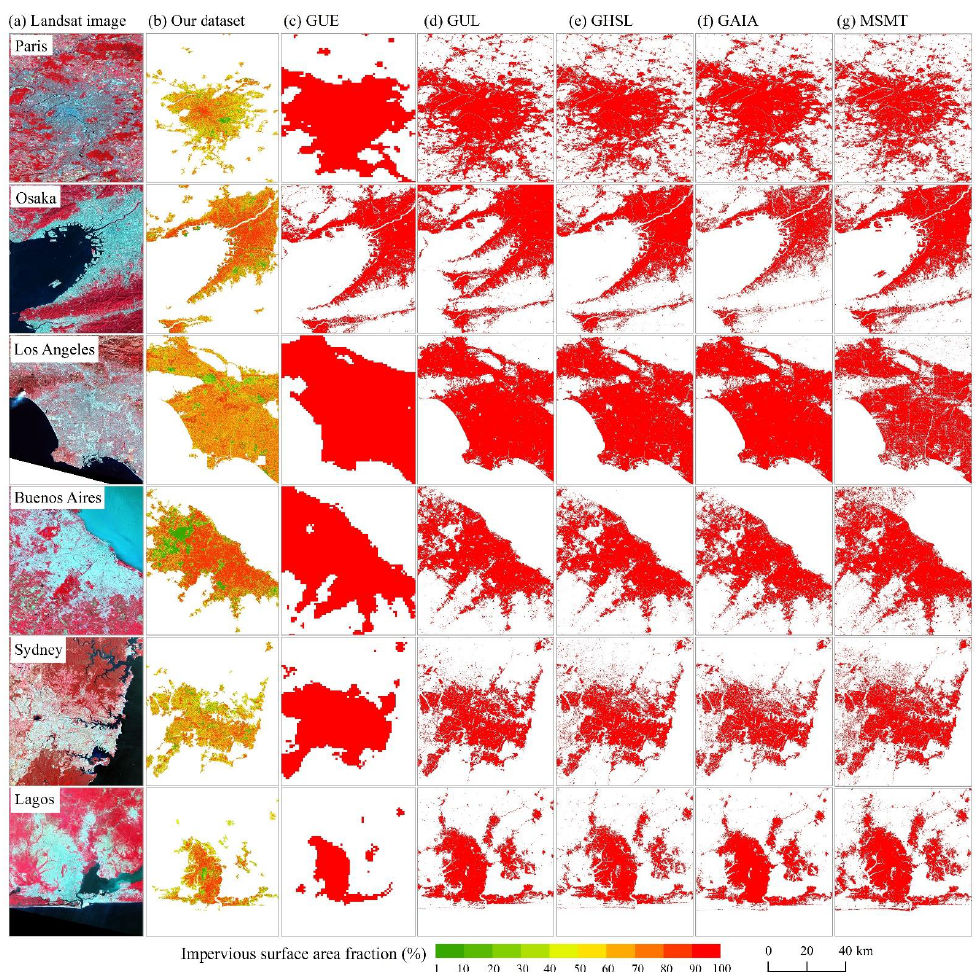
Figure 9. Comparisons between our dataset and other existing datasets. (GUE, global urban expan- sion [21]; GUL, global urban land [25]; GHSL, global human settlement layer [23]; GAIA, global artificial impervious area [9]; and MSMT, global ISA